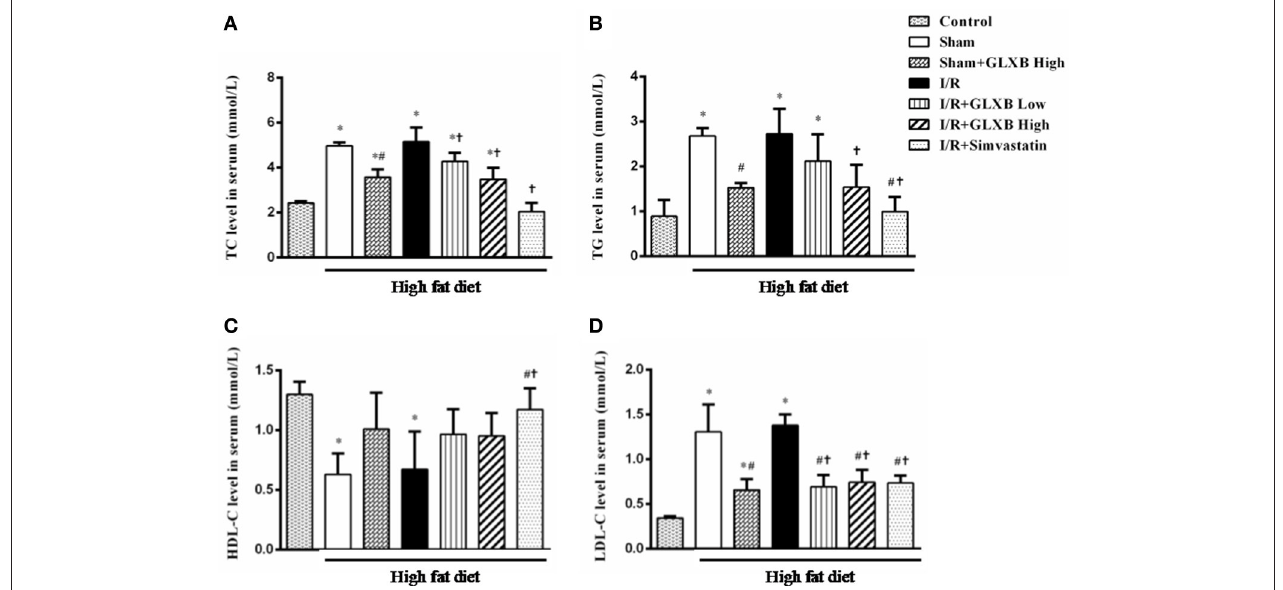
FIGURE 2 | The effect of GLXB on the level of serum TC, TG, HDL-C, and LDL-C in rat. (A) The level of serum TC in different group. (B) The level of serum TG in different group. (C) The level of serum HDL-C in different group. (D) The level of serum LDL-C in different group. Data are mean ± SEM, n = 6. * P < 0.05 vs. Control group, # P < 0.05 vs. Sham group, † P < 0.05 vs. I/R